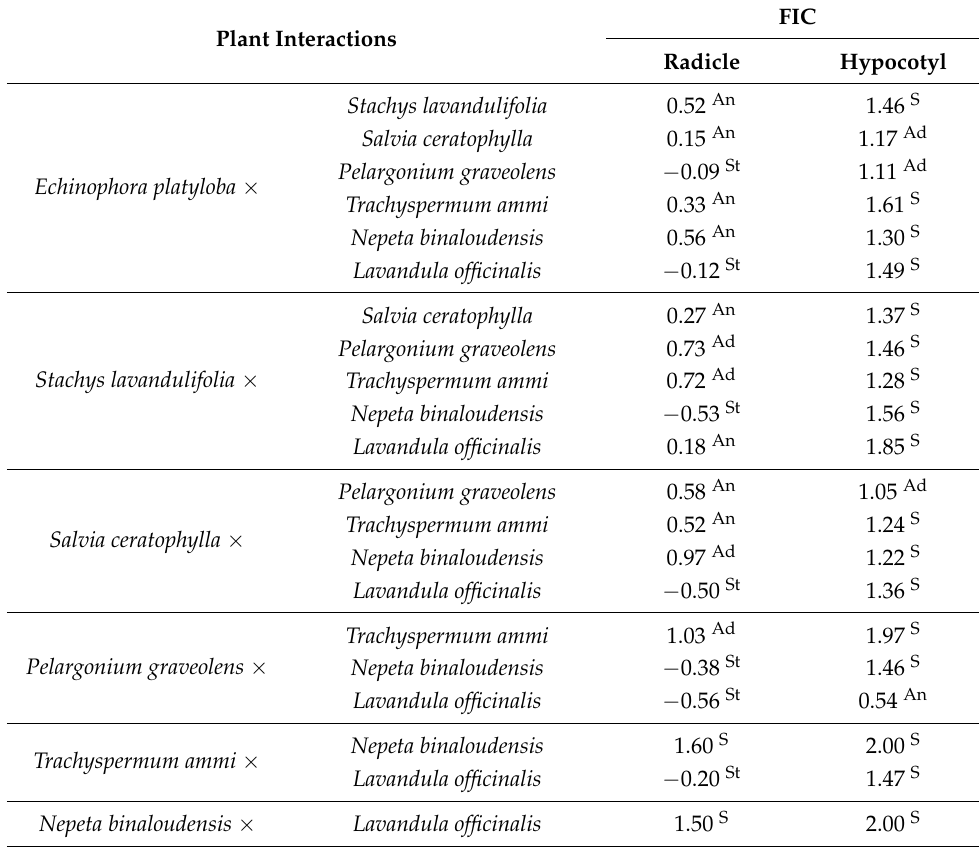
Table 4. Fractional Inhibitory Concentration (FIC) of combinations among the strongest inhibitory plants using EC 25 of lettuce radicle and